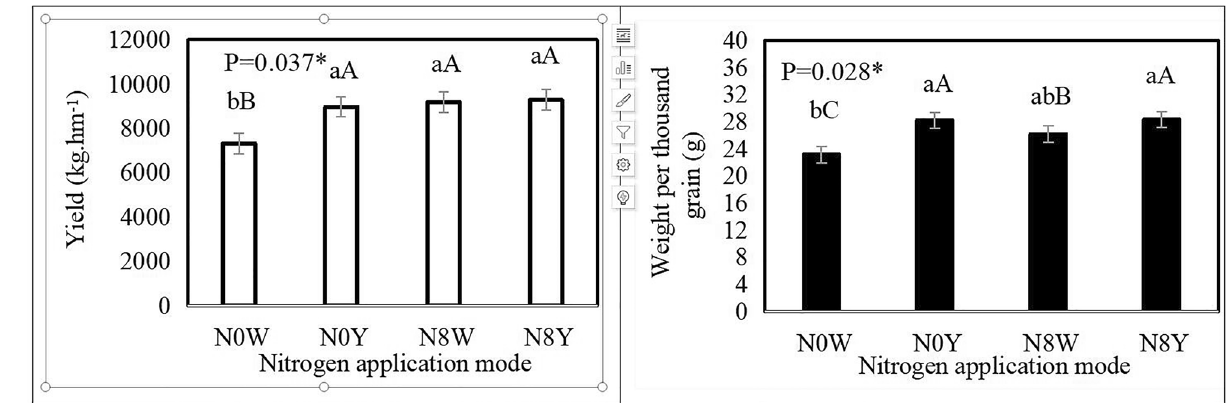
Figure 5. Comparison of yield and thousand grain weight under different nitrogen application patterns. *Lowercase English letters indicates significant difference at 0.05 level, **uppercase English letters indicates significant difference at 0.01 level.